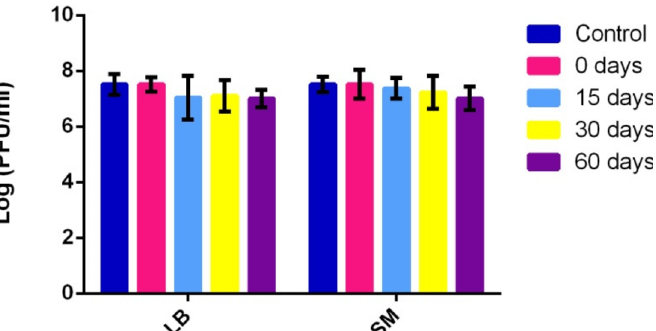
Figure 3. Stability of phage vRsoP-WF2 suspensions preserved in LB medium and in SM buffer at 4 ◦ C over time. Titration was carried out by the double layer agar method on CPG plates. Data are the means for assays performed at least in triplicate, and error bars indicate variation as the standard deviation. No statistical differences were